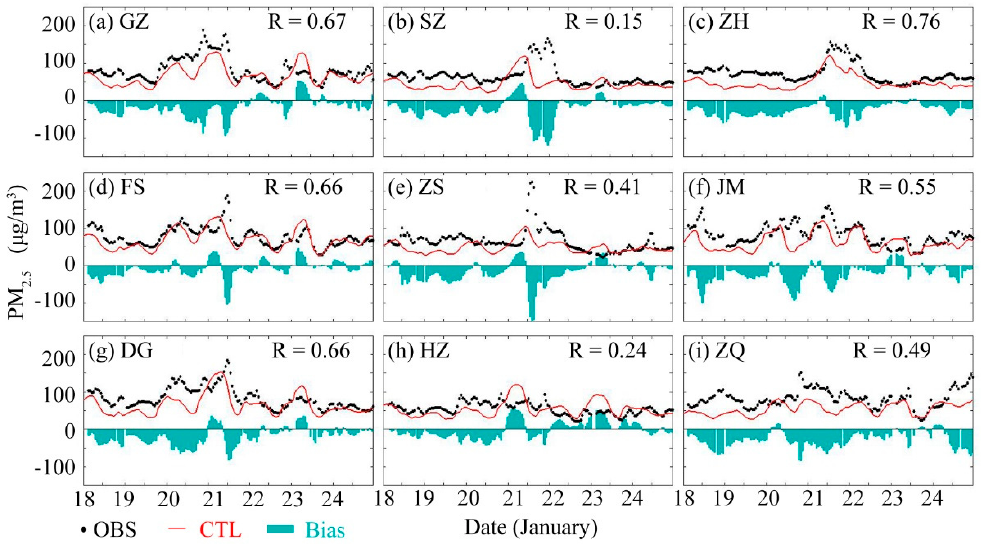
Figure 7. Time series of the hourly PM 2.5 concentration in cities in the PRD. From ( a ) to ( i ): GZ, SZ, ZH, FS, ZS, JM, DG, HZ, and ZQ, respectively. OBS values (black solid points, “ • ”), simulated values (CTL, solid red line, “-”), and deviation value (bias, cyan, “ ▃ ”). Table 3. Statistics of the hourly simulation results of the PM 2.5 concentration in cities in the PRD.